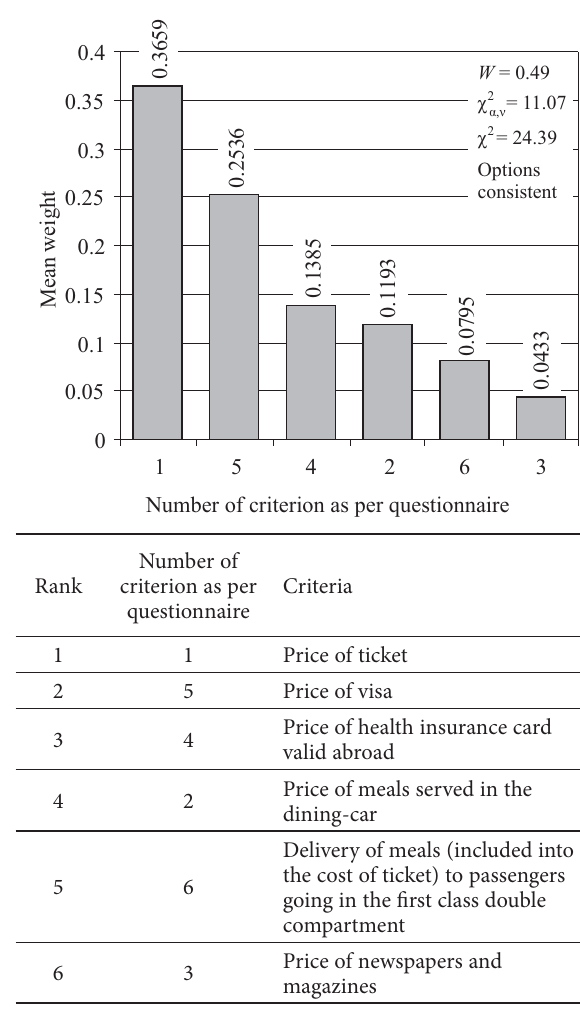
Fig. 5. Th e bar diagram showing the importance of criteria related to the price of the trip determined based